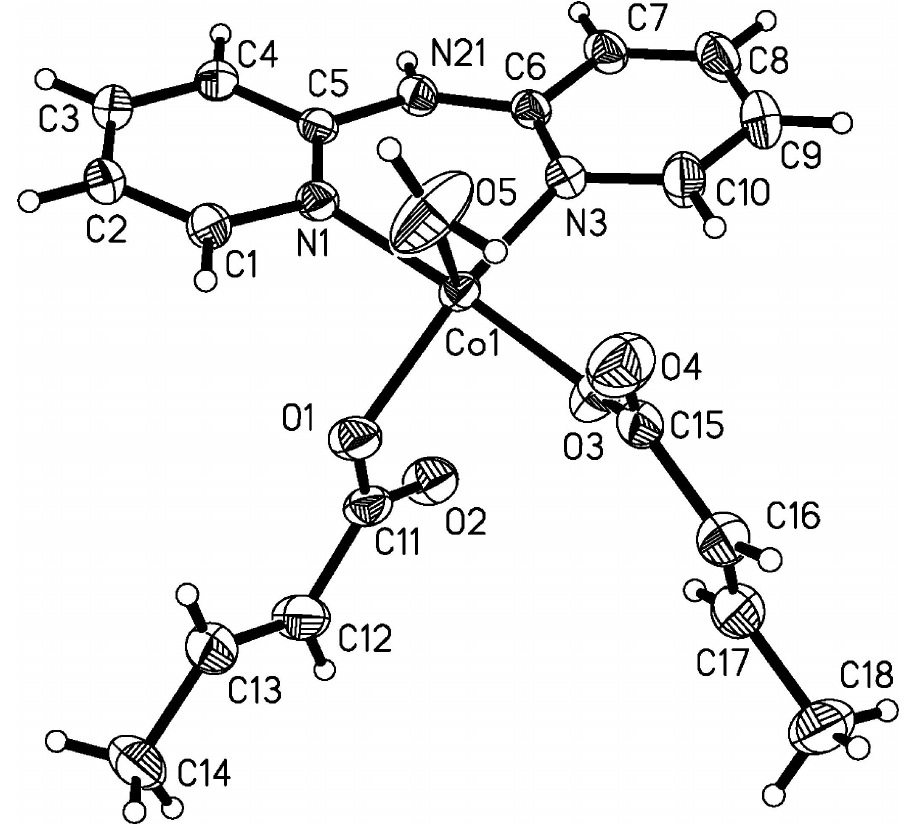
The molecular structure of the title complex, showing 30% probability displacement ellipsoids and the atomic numbering scheme. H atoms are shown as spheres of arbitrary